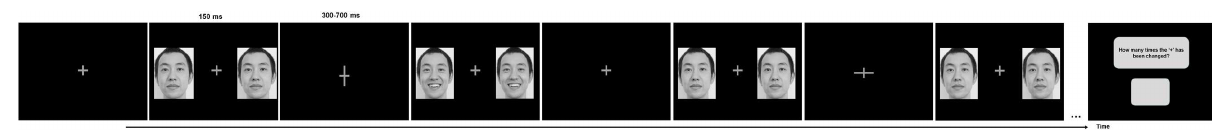
Frontiers in Psychology |